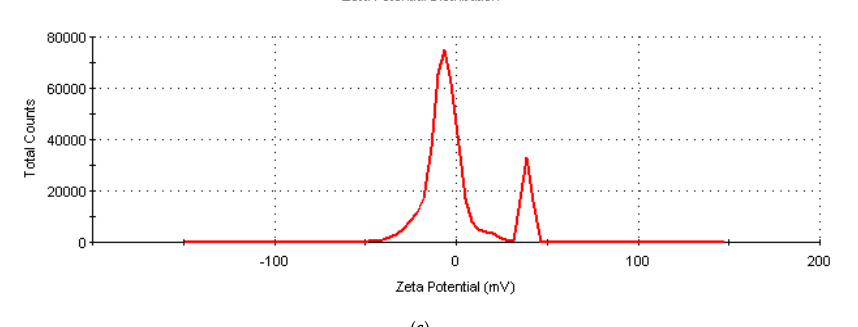
Figure 10. Surface Zeta potential of nanocellulose GNFC/H 2 SO 4 , GNFC/NaClO, and GNFC/NaOH hydrolysis. ( a ) Surface Zeta potential of nanocellulose GNFC/H 2 SO 4 hydrolysis. ( b ) Surface Zeta potential of GNFC/NaClO hydrolysis. ( c ) Surface Zeta potential of GNFC/NaOH hydrolysis. The nanocellulose samples prepared by the three methods were measured and compared with the Real Sample (RSNFC), shown in Figure 11a–d. They were found al- most similar and at the same separation time .